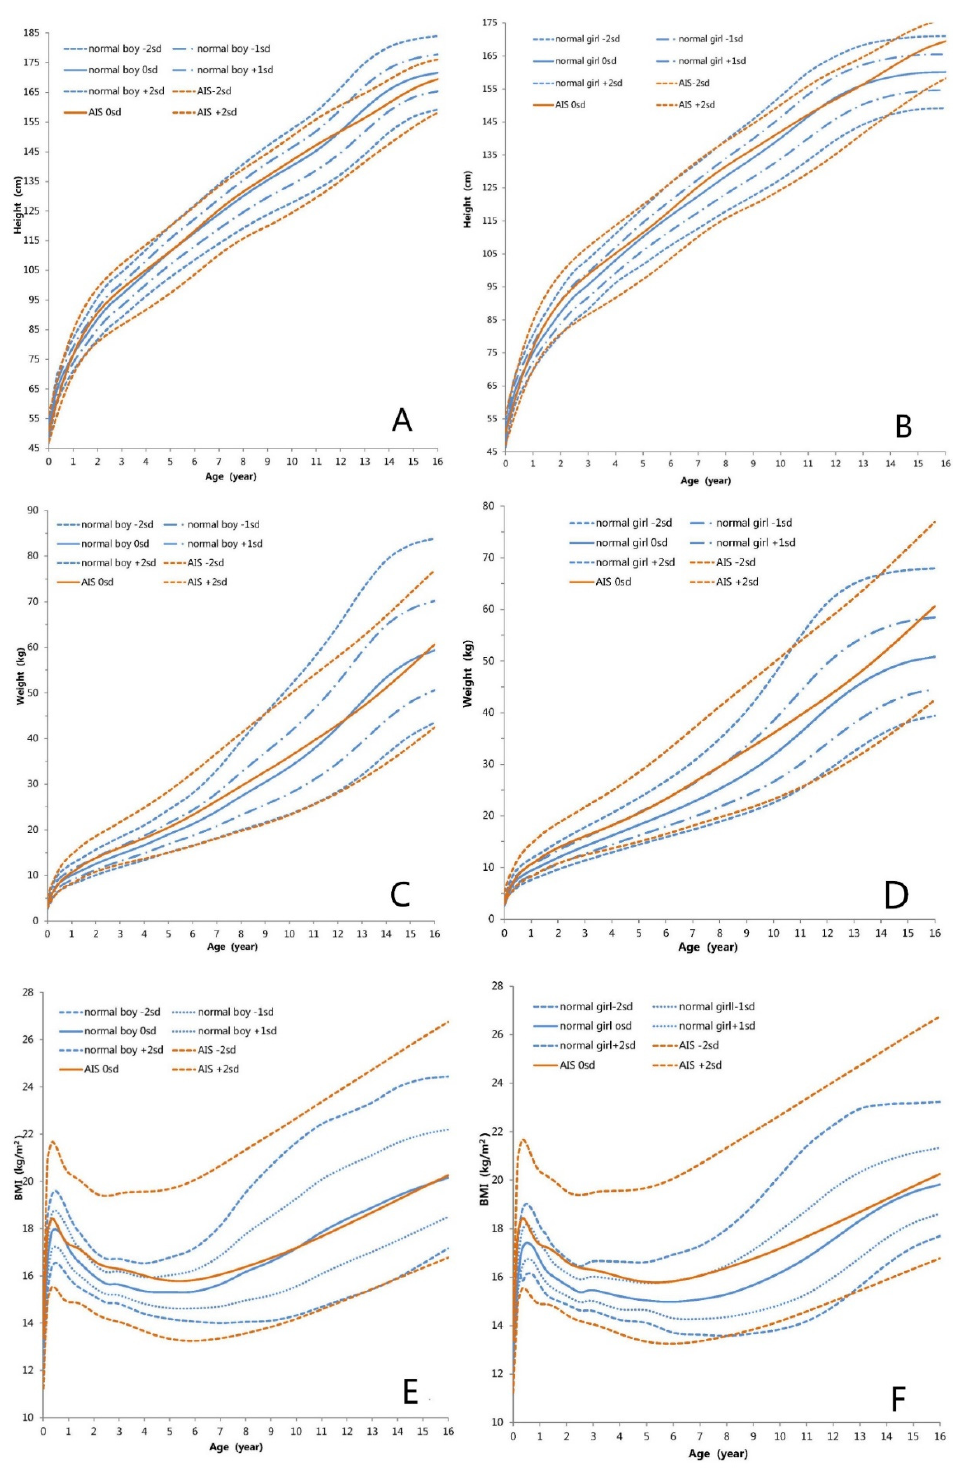
Figure 3. Standard deviation height, weight and BMI growth curves between children with AIS and Chinese boys and girls (0–16 years old). ( A ): Height standard deviation curve of Chinese boys; ( B ): Height standard deviation curve of Chinese girls; ( C ): Weight standard deviation curve of Chinese boys; ( D ): Weight standard deviation curve of Chinese girls; ( E ): BMI standard deviation curve of Chinese boys; ( F ): BMI standard deviation curve of Chinese girls; Blue indicates normal Chinese boys or girls. Red indicates patients with AIS. sd = standard deviation scores.